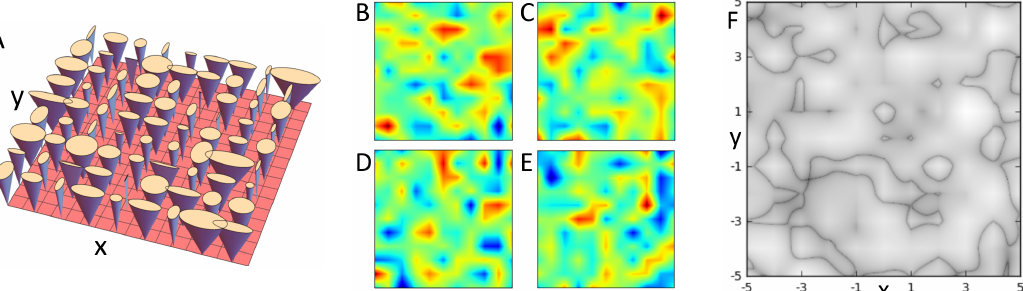
Figure 1: Introduction to the gravitational view of Dirac-carrier velocity